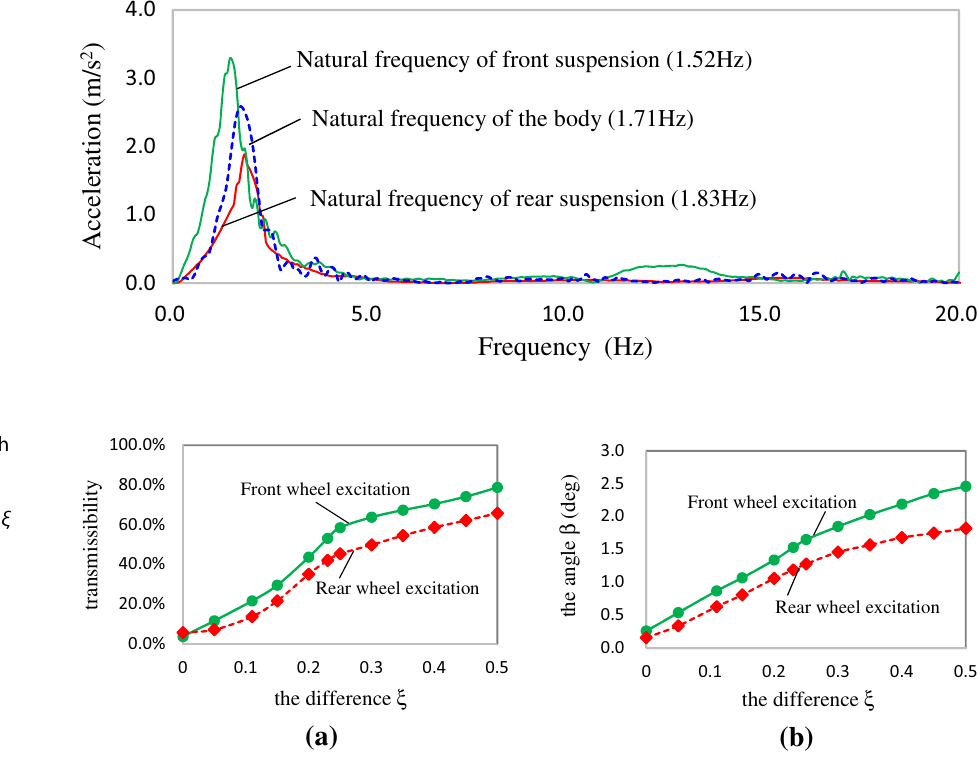
Fig. 5 Vibration test data with different ξ . a Transmissibility with different ξ . b Maximum pitching angle with different